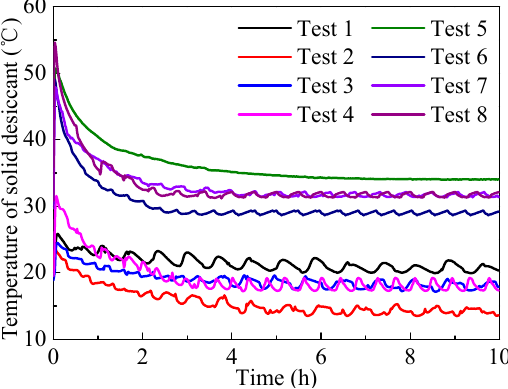
Figure 13. Variation of the average temperature of solid desiccant of the whole dehumidification device.